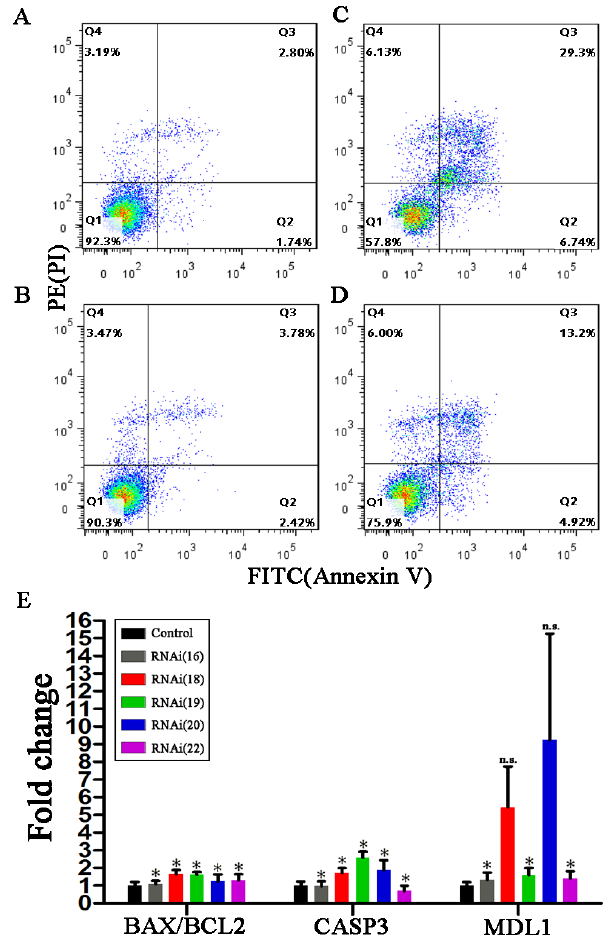
Figure 3. RNAi and cellular experiments for validation. PC-9 cells were divided into six groups named 16, 18, 19, 20, 22, and control for transfection using plasmids containing 16-nt, 18-nt, 19-nt, 20-nt, 22-nt segments, and their controls (Figure 2B). Each group had three replicate samples for plasmid transfection and cell apoptosis measurement. The 19-nt and 20-nt segments significantly induced cell apoptosis, whereas the 16-nt, 18-nt, and 22-nt did not show significantly positive results. The samples in this figure were selected randomly from the control ( A ), 18 ( B ), 19 ( C ), and 20 ( D ) group. ( E ). The experimental results by qPCR assays were consistent with those using Annexin V/PI staining and detection. The primers of MDL1 were used to amplify both MDL1 and MDL1AS , as they are sense–antisense transcripts from the same loci [9] and are predicted to be markers which can indicate the activities of mitochondria and even the whole cells.